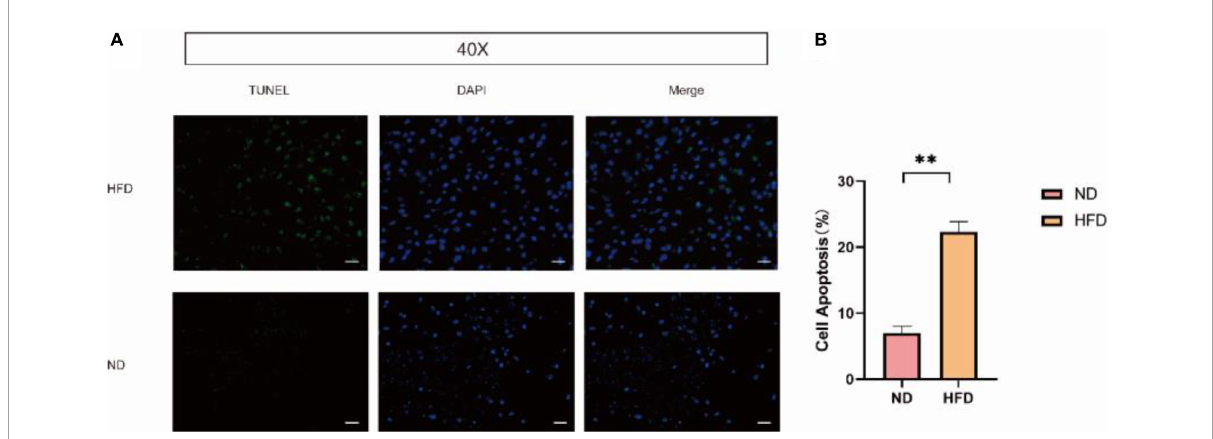
FIGURE5 A HFD boosted cell apoptosis in mice brain. (A) TUNEL staining was applied to assess the effects of HFD induced on the apoptosis of brain cell. Scale bars = 50 µ m. (B) Percentage of TUNEL-positive cells by TUNEL staining (n = 3/group) ** p < 0.01.